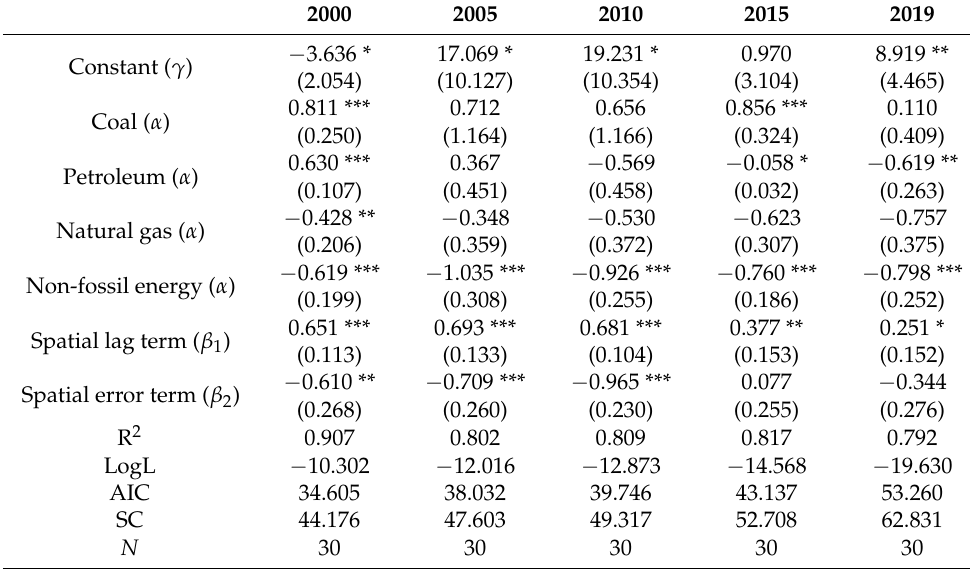
Table 5. Spatial regression results for per capita CO 2 emissions in China (five-time sections), based on the SEMLD